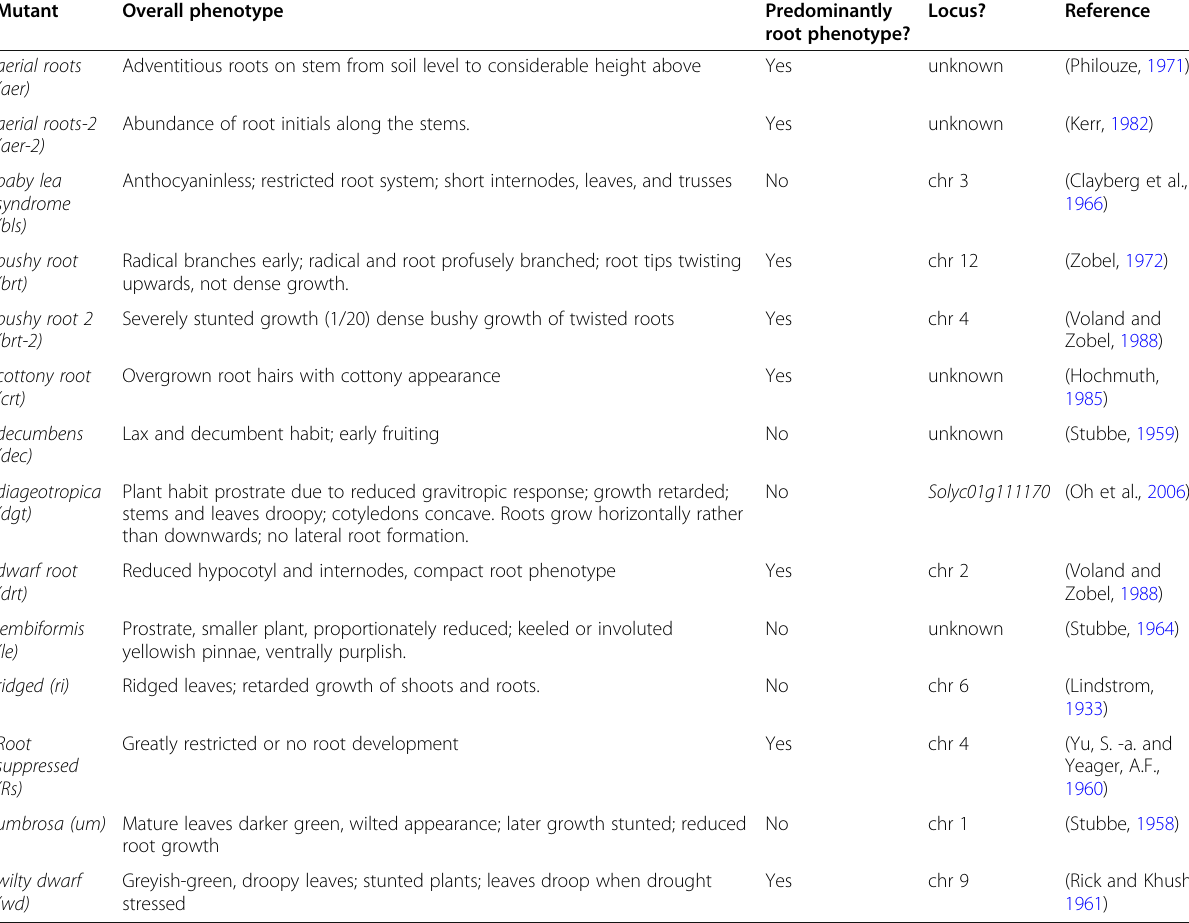
Locus? root phenotype?